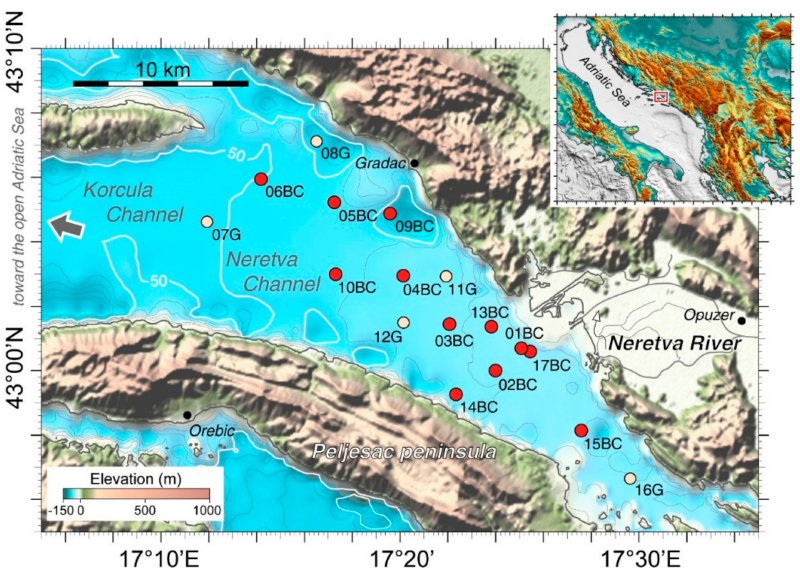
Figure 1. Study area and sampling locations. Shaded relief image derived from bathymetric data with sun illumination from NW, 45 ◦ over the horizon and no vertical exaggeration (grid resolution 10 m). Elevation and bathymetry data from EMODnet gridded data (www.emodnet.eu / bathymetry). Filled red and pink circles indicate box corer and grab samples locations, respectively. Bathymetry contour interval is 10 m. Red box in the inset indicates the study